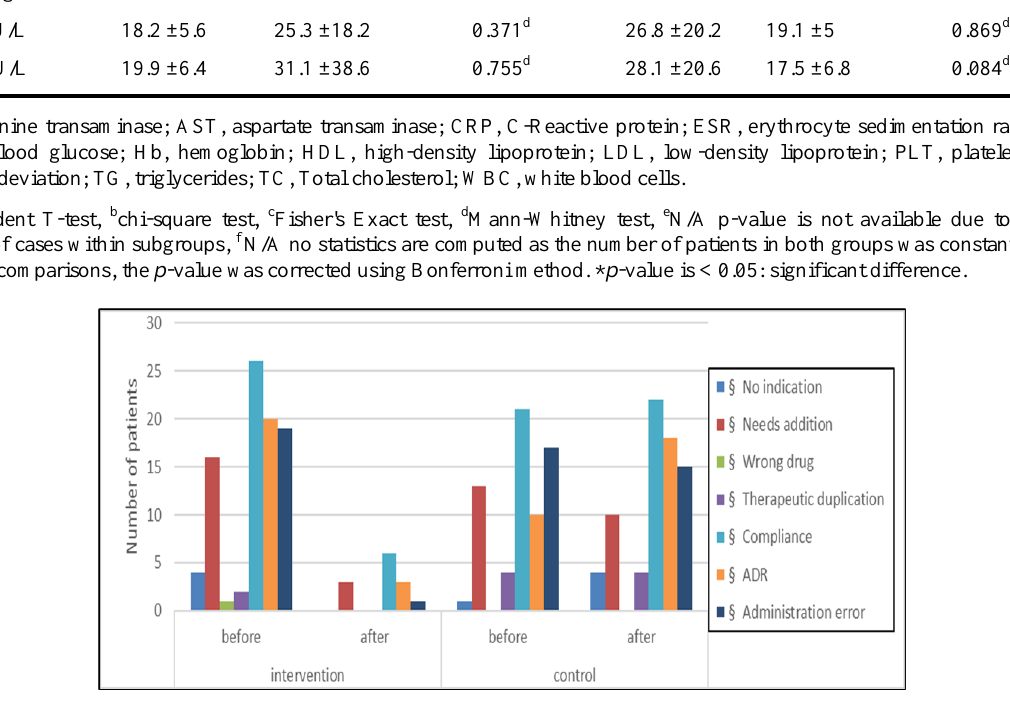
Fig. 4. Histograms showing the number of patients suffering from drug-related problems among the studied groups at baseline and after the end of the